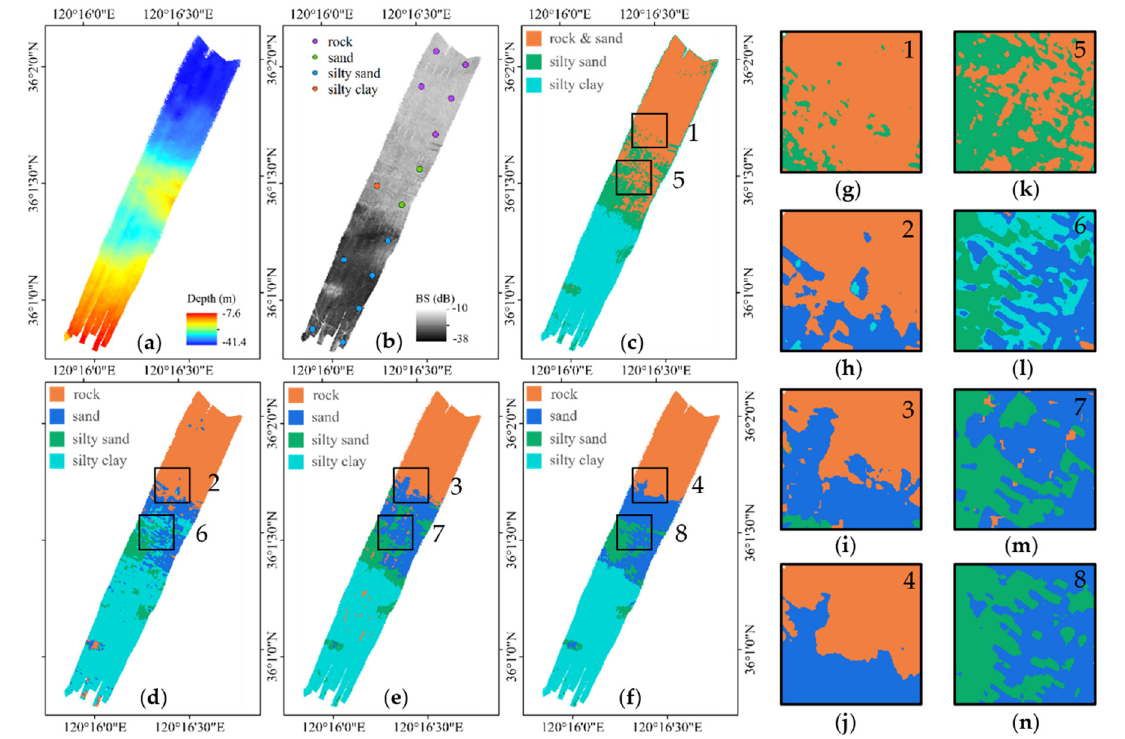
Figure 14. The comparison of sediment maps of different classifiers in Area-II. ( a ) Bathymetry of Area-II; ( b ) BS mosaic and sampling information of Area-II; ( c – f ) are the sediment maps of DFC, BPNN, SVM, our method, respectively; ( g – j ) are the details of areas 1–4 respectively; ( k – n ) are the details of areas 5–8 respectively.